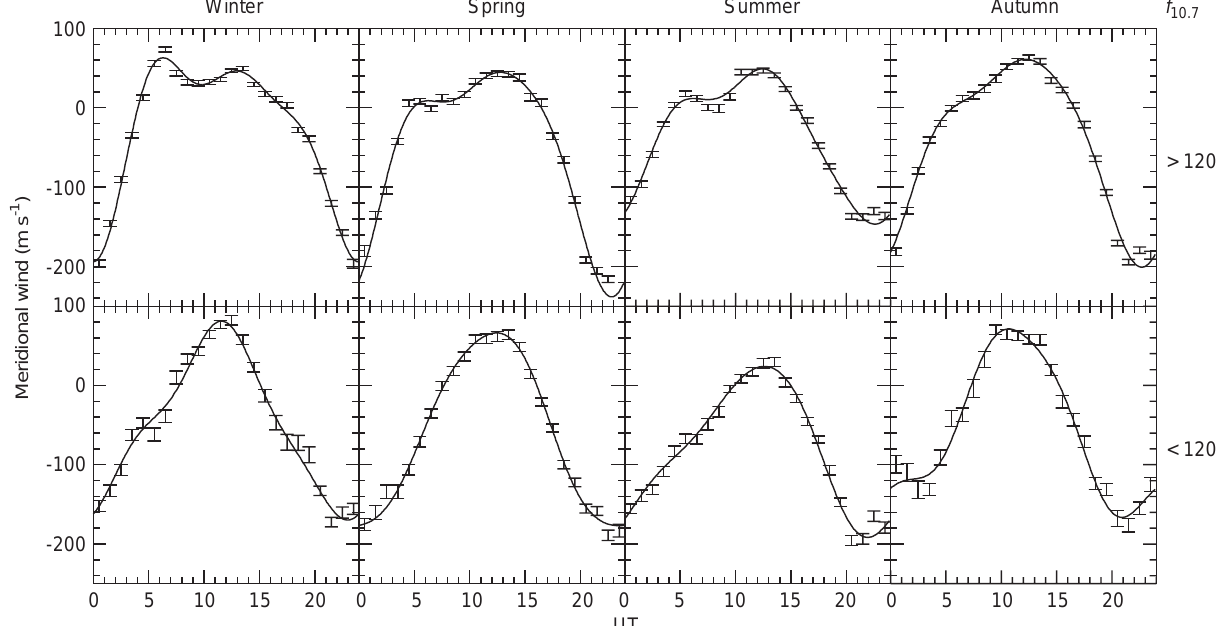
Fig. 4. Mean wind patterns ( points with errorbars ) and the harmonic fit ( solid line ) at 257 km height. Di(cid:128)erent classes are represented as in Table 2. The first line of boxes corresponds to high solar fluxes, the